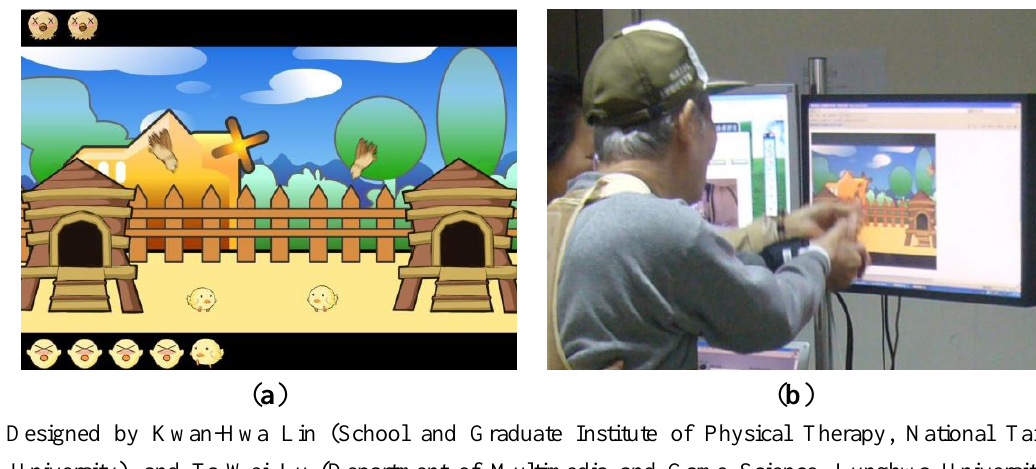
Figure C1. Example of 3D animation interactive games with touch screen